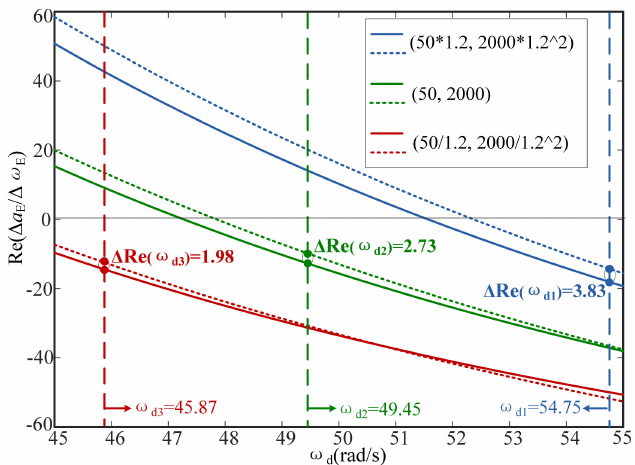
Figure 15. Impacts of di ff erent PLL controller parameters ( k p4 , k i4 ) on the frequency responses of the real part of the transfer function ∆ a E / ∆ ω E . (The dotted lines are cases ignoring the e ff ect of frequency variation, and the solid lines represent the cases where it is considered. ∆ Re( ω d ) is the di ff erence between the values of Re[ ∆ a E / ∆ ω E ( j ω d )] of them.).